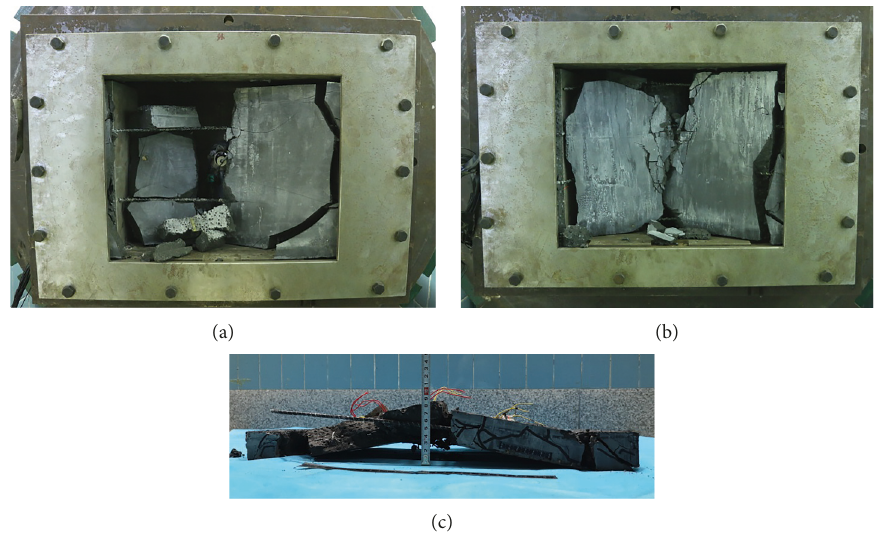
Figure 7: Typical failure of specimens. (a) BS1-2. (b) BS2-3 (front view). (c) BS2-3 (side view).